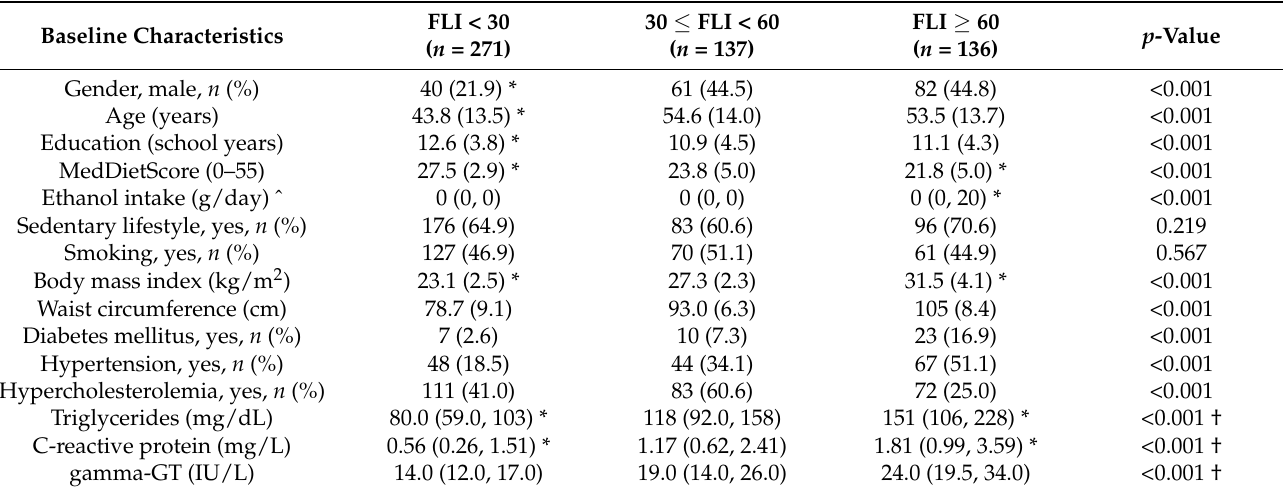
Table 1. Socio-demographic, lifestyle and clinical characteristics of the participants in respect to fatty